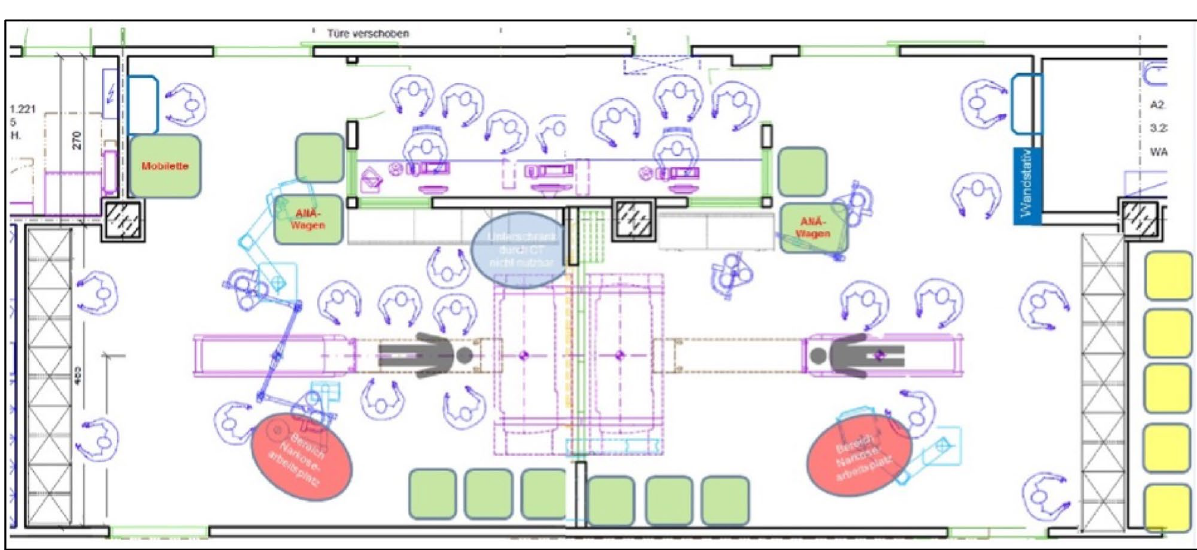
Figure 2. Schematic illustration of the entire trauma suite including the radiology workstation (top